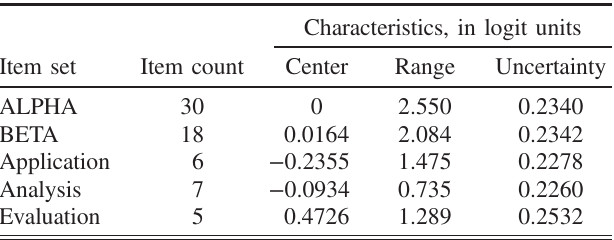
TABLE VIII. Subscales in the CML Rasch calibrated PSCI test. Uncertainty ¼ average standard error of the item location.